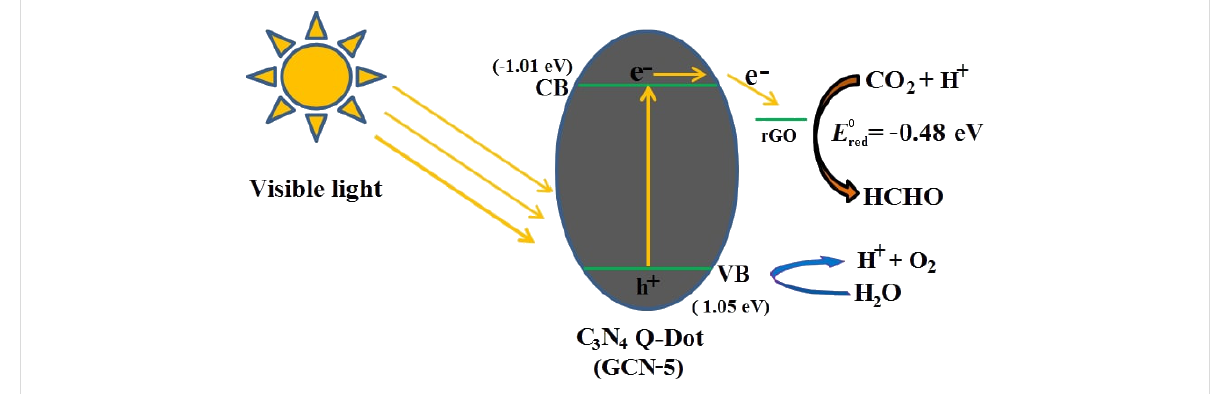
Figure 13: Possible photoreduction mechanism of CO 2 to HCHO in the presence of the GCN-5 catalyst sample under visible light illumination.